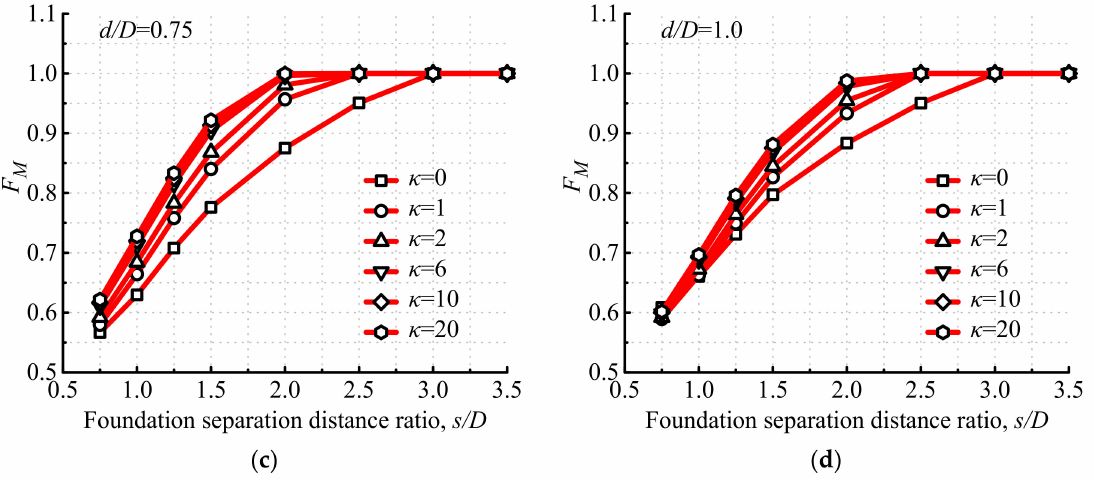
Figure 19. Normalized moment group effect factors of tetrapod bucket foundations under various κ :